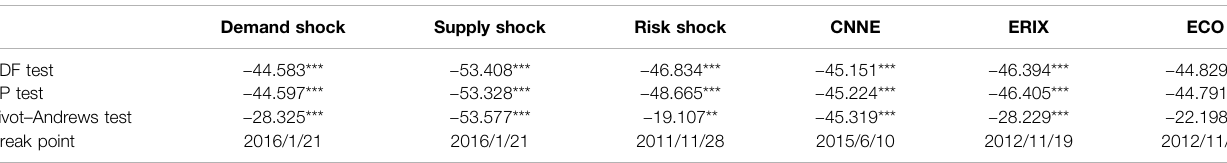
TABLE 2 | The results of the three types of unit root test.